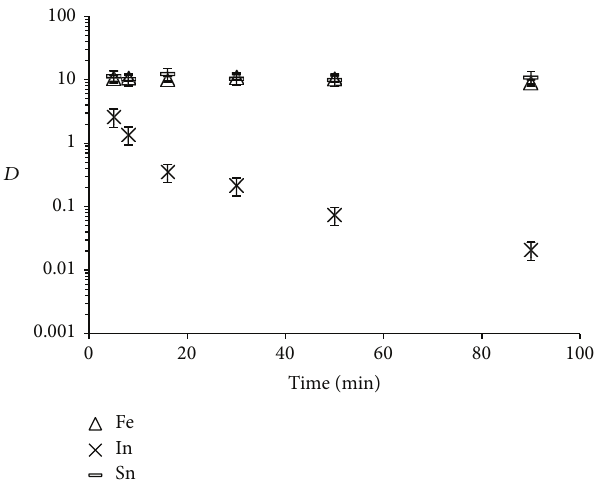
Figure 5: Distribution ratios of Al(III), Cu(II), Fe(III), In(III), Sn(IV), and Zn(II) in 1M chloride media at 293 K and 𝜃 = 1 plotted as a function of the hydrogen ion concentration. The organic phase was 0.1M D2EHPA diluted in